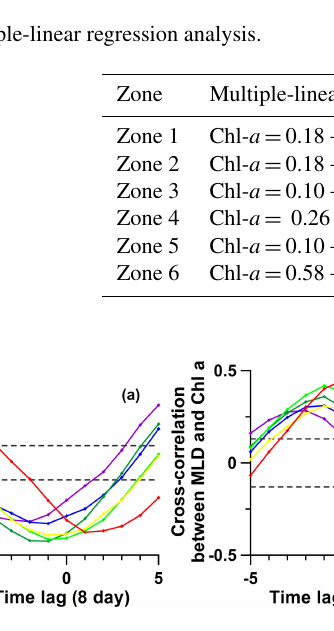
Figure 8. Cross-correlation of (a) SST and (b) MLD with Chl a in six zones. Grey dashed horizontal line represents the 99% confi- dence interval. Each unit on the x axis represents an 8-day period. Zones 1–6 are represented by violet, blue, green, light green, yellow and red lines respectively.